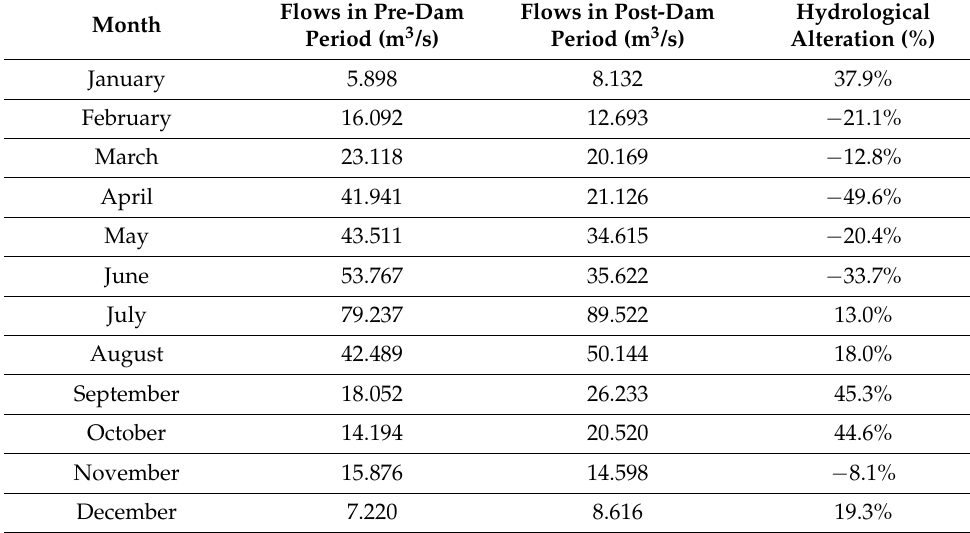
Table 3. Mean flow and alteration before and after dam